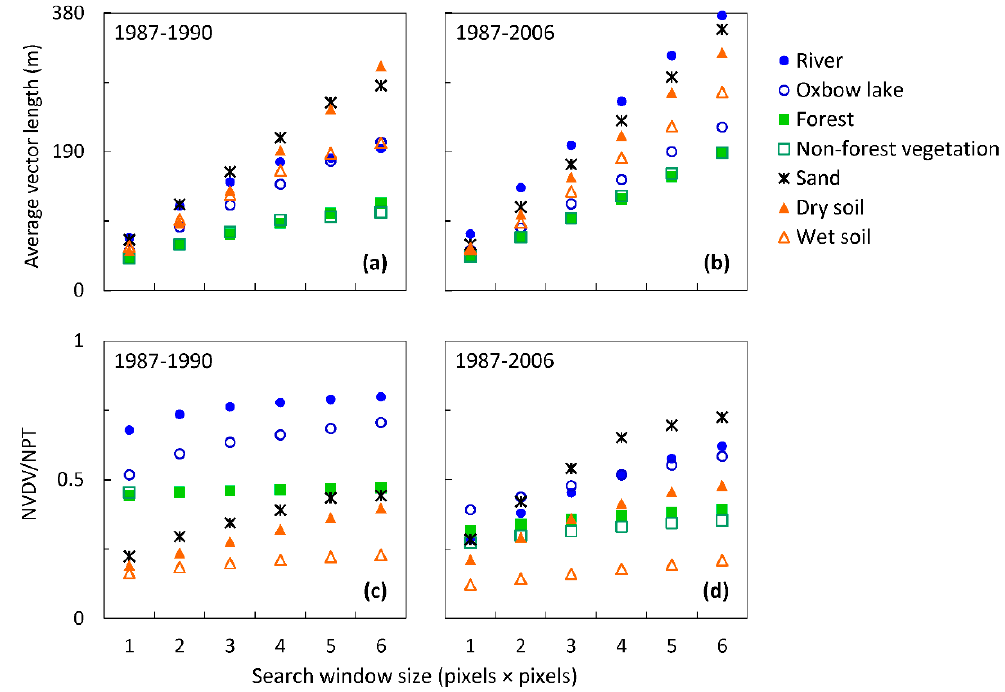
Figure 4. Sensitivity of MCC method to search window size. Average valid displacement vector length for the periods of ( a ) 1987–1990 and ( b ) 1987–2006, and the ratio of the number of valid displacement vectors (NVDV) to the number of possible templates (NPT) for the periods of ( c ) 1987–1990 and ( d ) 1987–2006 as a function of search window size. Template size = 13 × 13 pixels, MCC threshold = 0.6.